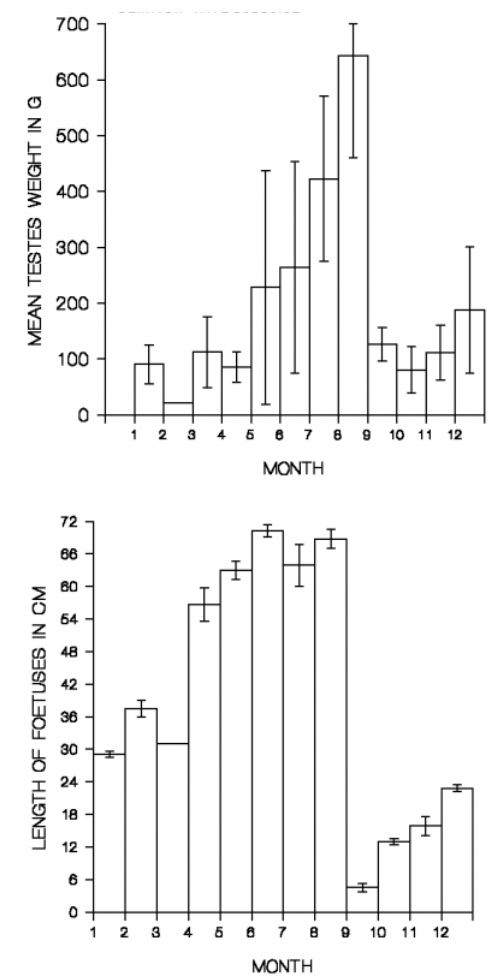
Fig. 10. Mean monthly lengths of por- poise